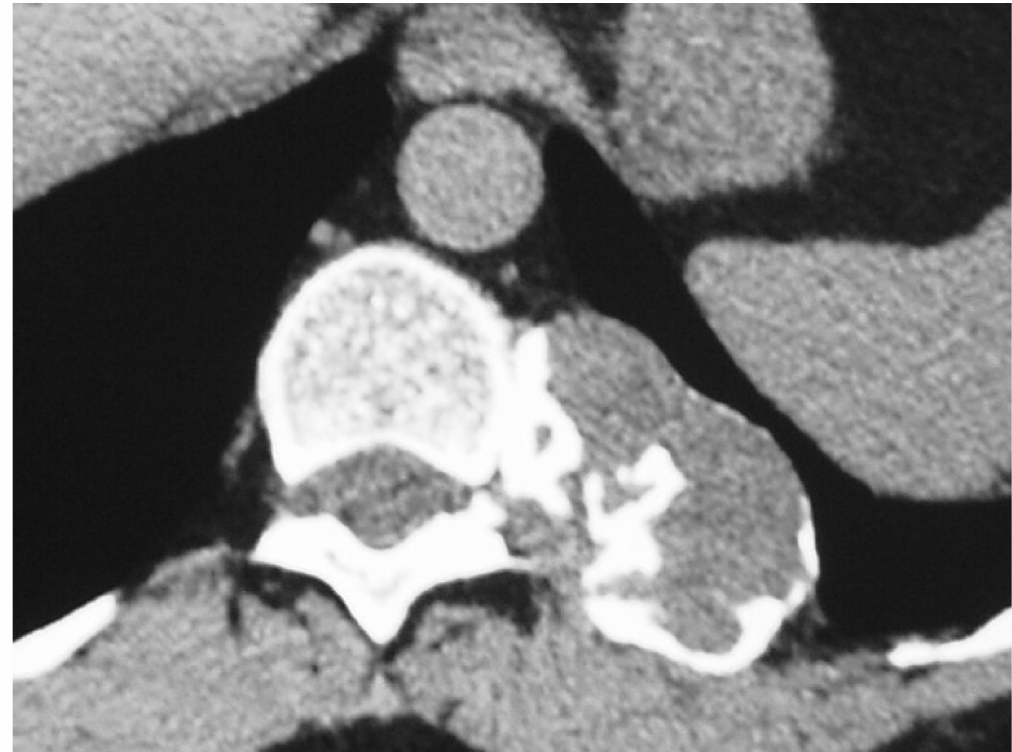
Figure 3. A 62-year-old female patient with grade 2 chondrosarcoma at the posterior rib adjacent to the costovertebral junction. Axial chest CT shows a soft tissue mass at the posterior rib with